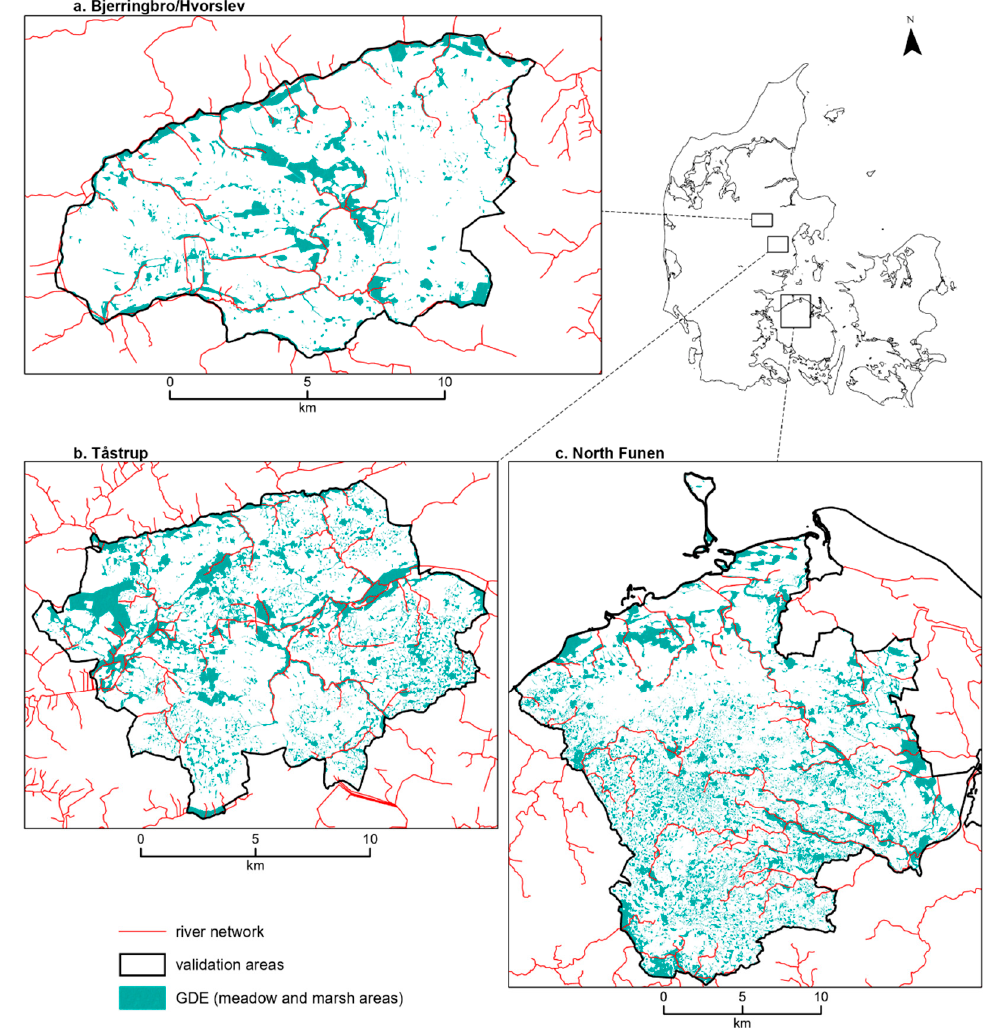
Figure 5. Spatial data used to validate the river valley bottom delineation tool consisting of three areas: ( a ) Bjerringbro/Hvorslev, ( b ) Tåstrup, and ( c ) North Funen with expertly digitized Groundwater Dependent Ecosystems (GDE) consisting of the nature types meadow and marsh [30].